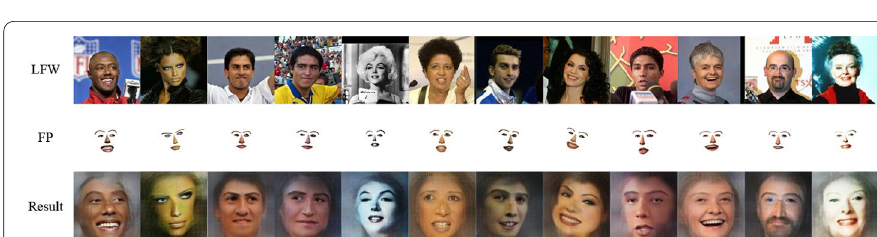
Fig. 12 Apply the model trained on CelebA to the LFW dataset. The first row is randomly selected images from LFW, and the last row is a synthetic portrait of our model. (FP is short for facial